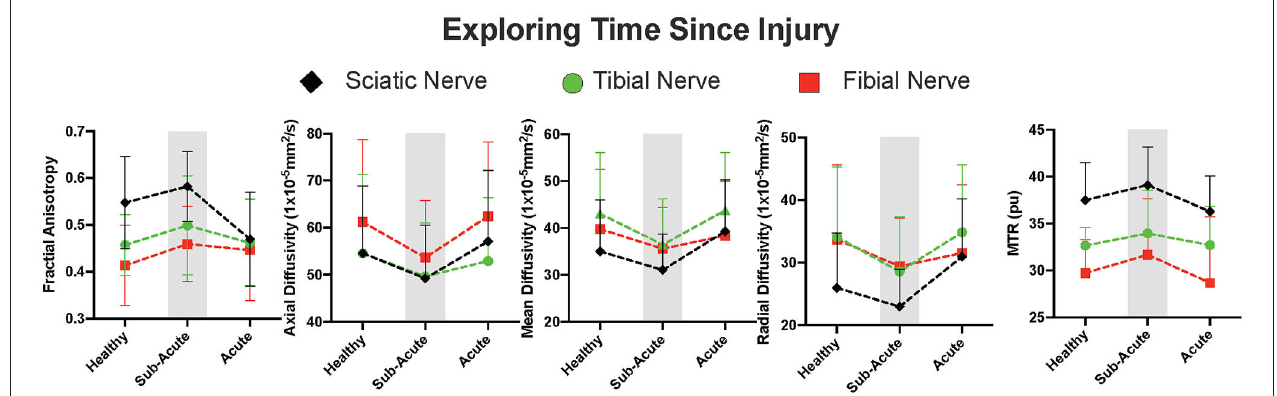
FIGURE 5 | Time since injury and nerve fiber integrity. An exploratory and qualitative analysis was performed where ankle injury participants were divided into those who were within 30 days from injury (sub-acute; gray panels) and those between 30 days and 3 months (acute) highlighting a sub-acute phase of nerve fiber damage. Reported data reflect average within slice values for each imaging